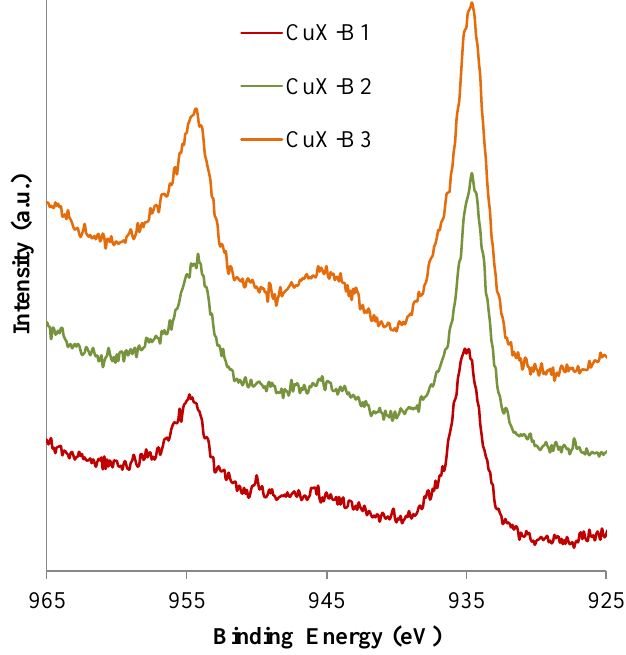
Figure 5. Cu 2p XPS spectra of the copper-exchanged zeolites.